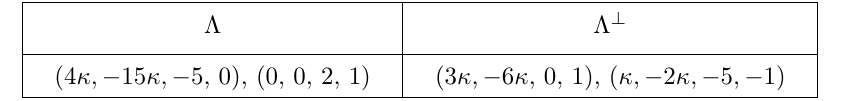
Table 7 . Generators for the lattices (cid:3) and (cid:3) ? for the attractor point at ’ = (cid:0) 1 =